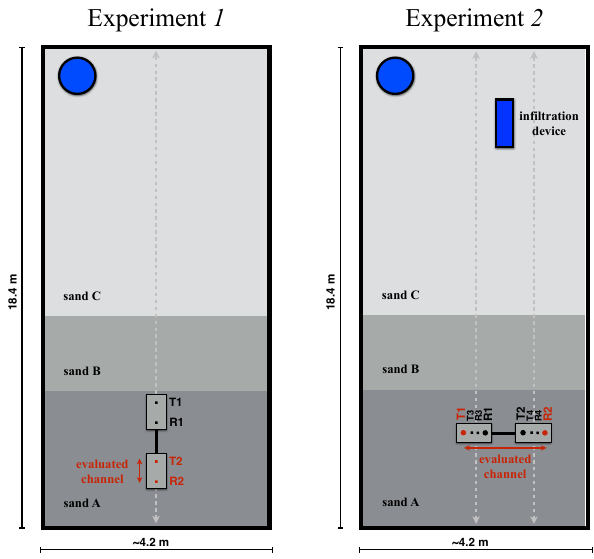
Figure 3. Overview of the measurement setup for both experiments. For experiment 1 (left side), four-channel GPR data were acquired at a center frequency of 400MHz along the center line of the struc- ture, while water was pumped into and out of the observation well marked by the blue circle. For experiment 2 (right side), eight- channel dual-frequency (200/600MHz) data were acquired perpen- dicular to the direction of movement. The channel evaluated for this paper is specifically marked for both cases (experiment 1: T2R2; experiment 2: T1R2). Note that the aspect ratio of the figure does not correspond to